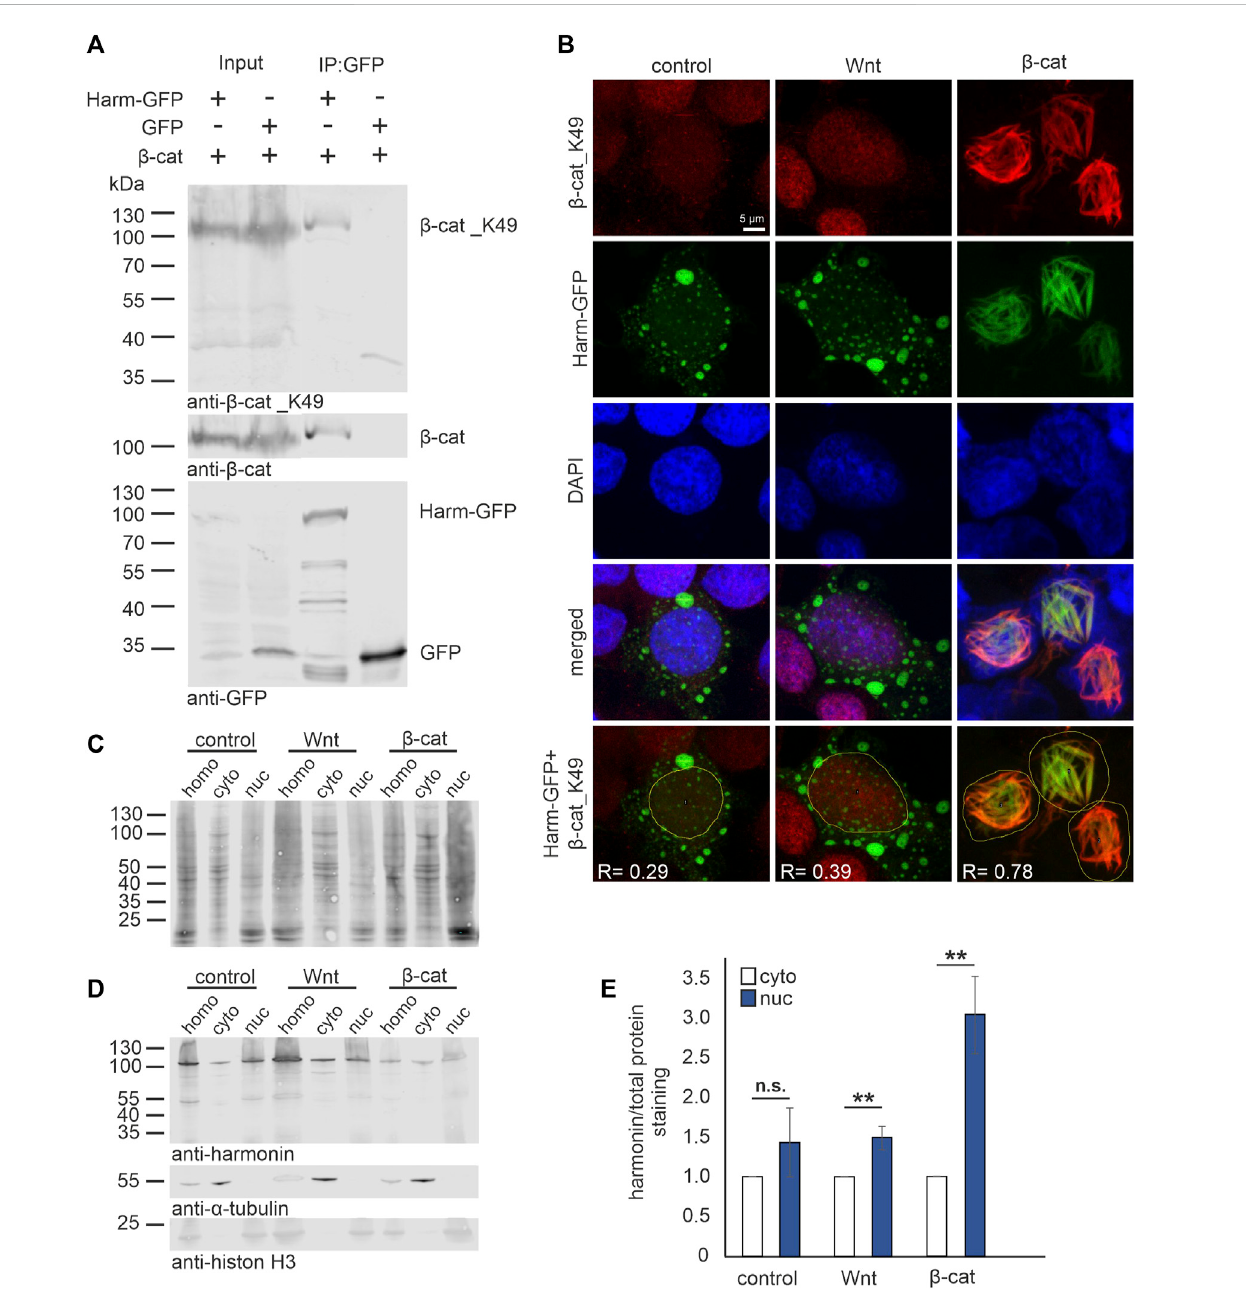
FIGURE 2 Harmonin interaction with acetylated β -catenin_K49 in the nucleus. (A) Western blot analysis of a representative GFP-Trap ® pull down shows the interaction between harmonin a1-GFP (Harm-GFP) and acetylated β -catenin_K49 ( β -cat_K49). HEK293T cells were transfected with β -cat and Harm-GFP or GFP alone, respectively. Harm-GFP but not GFP alone was able to precipitate β -catenin ( β -cat) as well as β -cat_K49; 12% polyacrylamide gel; N = 3 experiments. (B) Immuno fl uorescence localization of Harm-GFP (green) and β -cat_K49 (red) under different stimulation. HEK293T cells were transfected with Harm-GFP and stimulated for Wnt signaling with Wnt medium (Wnt) or transfection of β -cat. DAPI (blue) marks the nucleus. In unstimulated (control) state (left panel) (Pearson correlation coef fi cient: Harm-GFP and β -cat_K49: R = 0.29; n = 136 cells; N = 3 experiments) and after Wnt stimulation (middlepanel)(Pearsoncorrelationcoef fi cient:Harm-GFPand β -cat_K49:R=0.39; n =134cells;N=3experiments),Harm-GFPisdistributedinnucleusand cytosol of the cell. The β -cat_K49 staining is almost absent in the unstimulated state, however, there is an increase in anti- β -cat_K49 fl uorescence in the nucleus after Wnt stimulation. Additional transfection with β -cat (left panel) results in β -cat_K49 bundles in the nucleus with which Harm-GFP colocalizes. Analysis of Pearson correlation coef fi cient (lowest panel) reveals strong interaction between Harm-GFP and β -cat_K49 with value of R = 0.78 ( n = 169 cells; N=3experiments). (C – E) Westernblotanalysisofcellfractions(30 μ gtotalproteinloaded),separatedfromhomogenate(homo)incytosol(cyto)andnucleus (nuc).HEK293TcellsweretransfectedwithHarm-GFPandstimulatedforWntsignalingwithWntmediumortransfectionof β -cat.UnstimulatedHEK293cells served as control. (C) Staining of total protein amount was compared to (D) Harm-GFP staining in the fractions; α -Tubulin marks the cytosol fraction and histon H3 the nucleus fraction (15% polyacrylamide gel). Statistical analysis (E) reveals a non-signi fi cant increase of 1.4-fold of harmonin in unstimulated cells (control)butasigni fi cantincreaseof1.5-foldcomparingnucleartocytosolicharmonin(setto1)inWntstimulatedcells.Co-transfectionwith β -catresultsina signi fi cant increase of 3-fold of nuclear harmonin. Two-tailed Student ’ s t -test, ** p ≤ 0.01; N = 3 experiments.